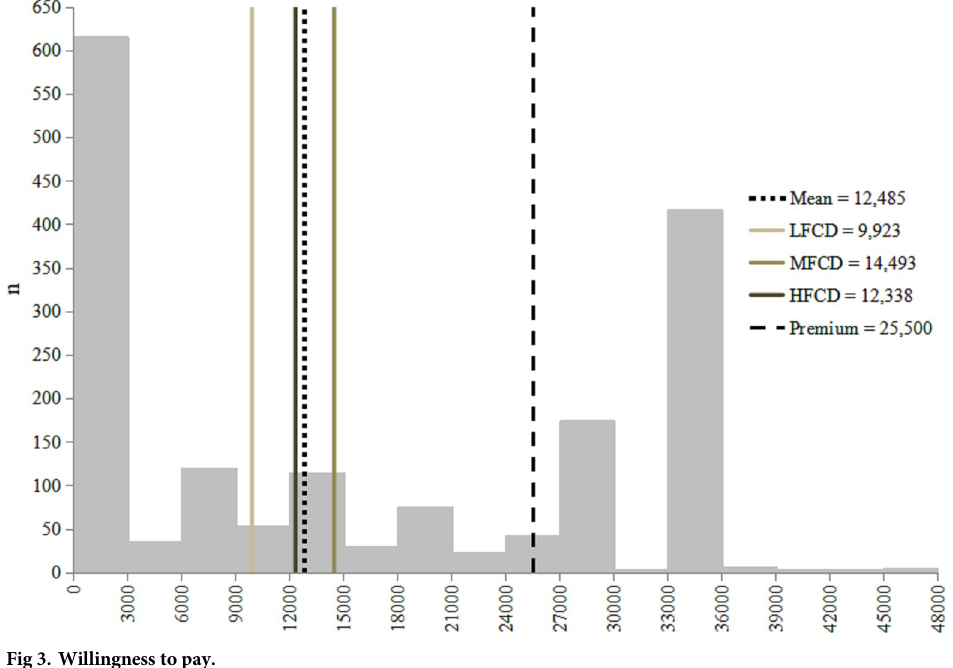
Fig 3. Willingness to